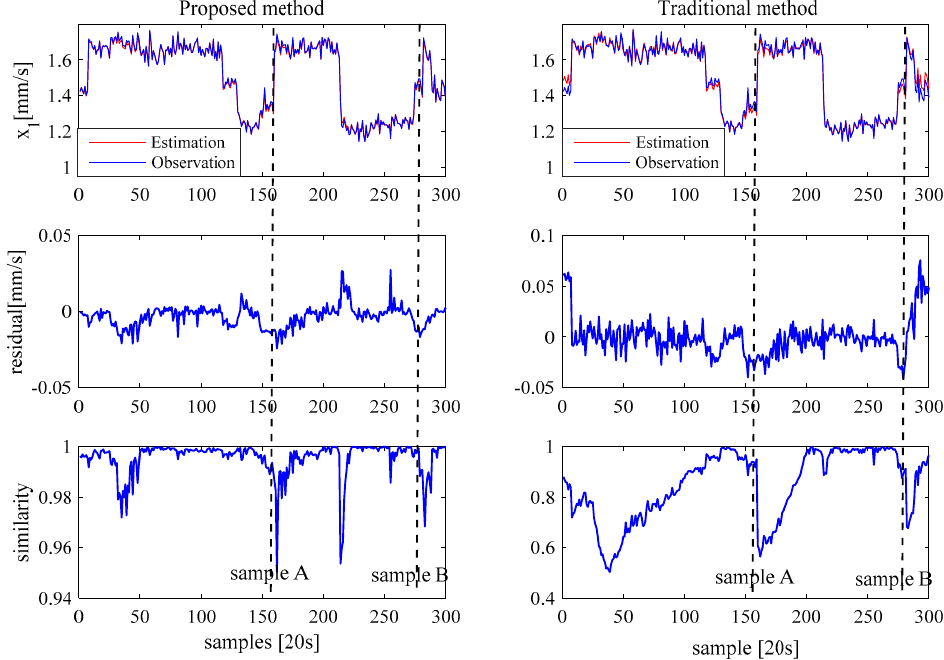
Figure 7. Comparison for proposed method and traditional method for horizontal vibration condition II.